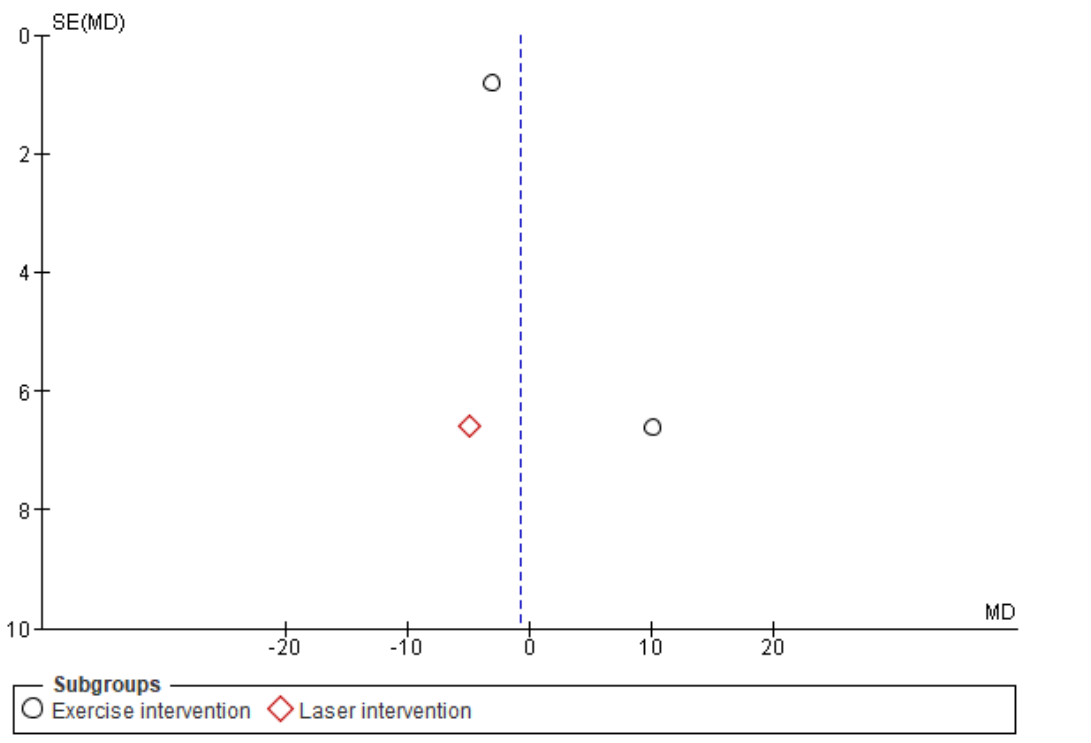
Figure 13. Funnel plot VR pain management intervention group vs. other pain management therapies group.